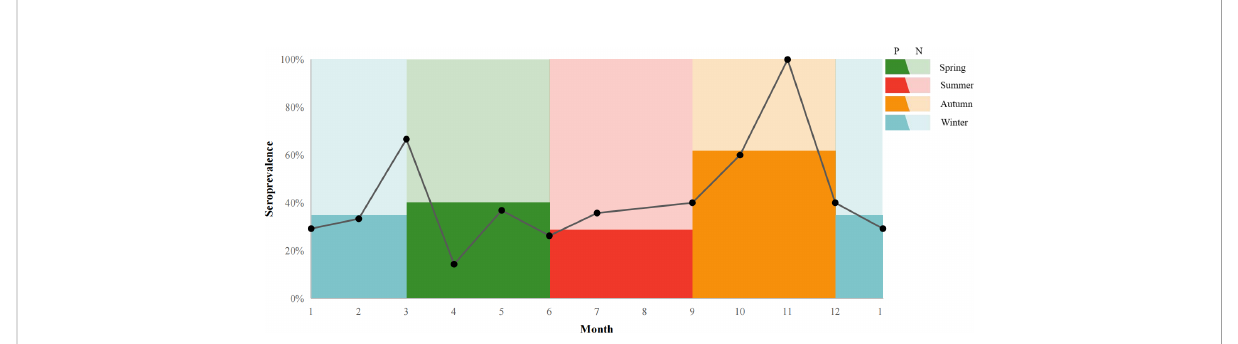
FIGURE 4 T. gondii seroprevalence giant pandas in different months. P: positive, N: negative. The line chart shows the seroprevalence in a different month. The colors in the background indicated the percentage of the seroprevalence (The dark color: positive; The light color: negative) in